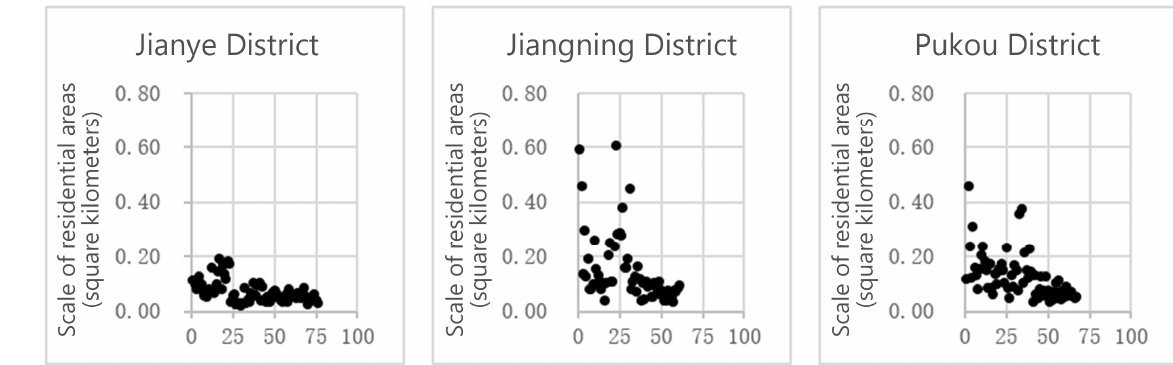
Figure 4. Area size of 204 residential areas in Jiangning, Jianye, and Pukou District.